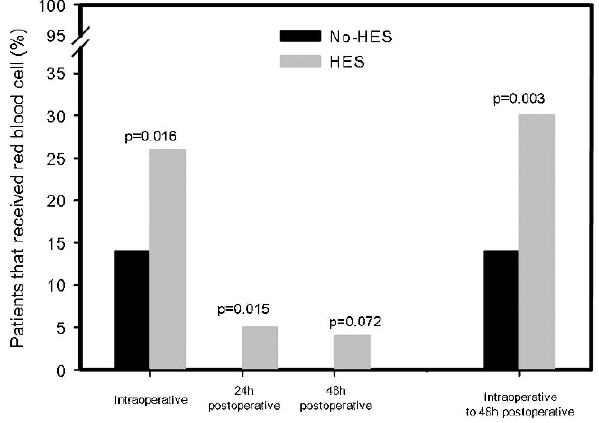
Perioperative RBC